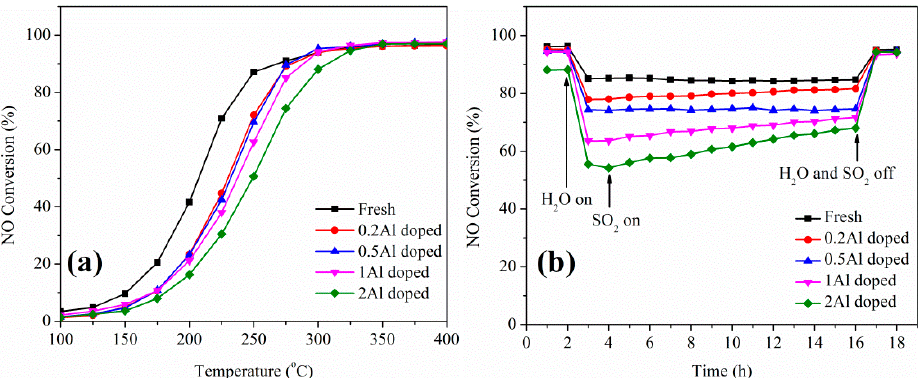
Figure 3. Influence of Al on catalytic performance: ( a ) NO x conversion versus temperature over the catalysts with different contents of Al 2 O 3 ; ( b ) effect of H 2 O and SO 2 on the NO conversion over the catalysts with different contents of Al 2 O 3 . Reaction conditions: [NH 3 ] = [NO] = 400 ppm, [O 2 ] = 0.5%, [SO 2 ] = 200 ppm and [H 2 O] = 30% for (b), balance N 2 , GHSV = 30000 h − 1 , H 2 O and SO 2 resistance test temperature = 300 °C.